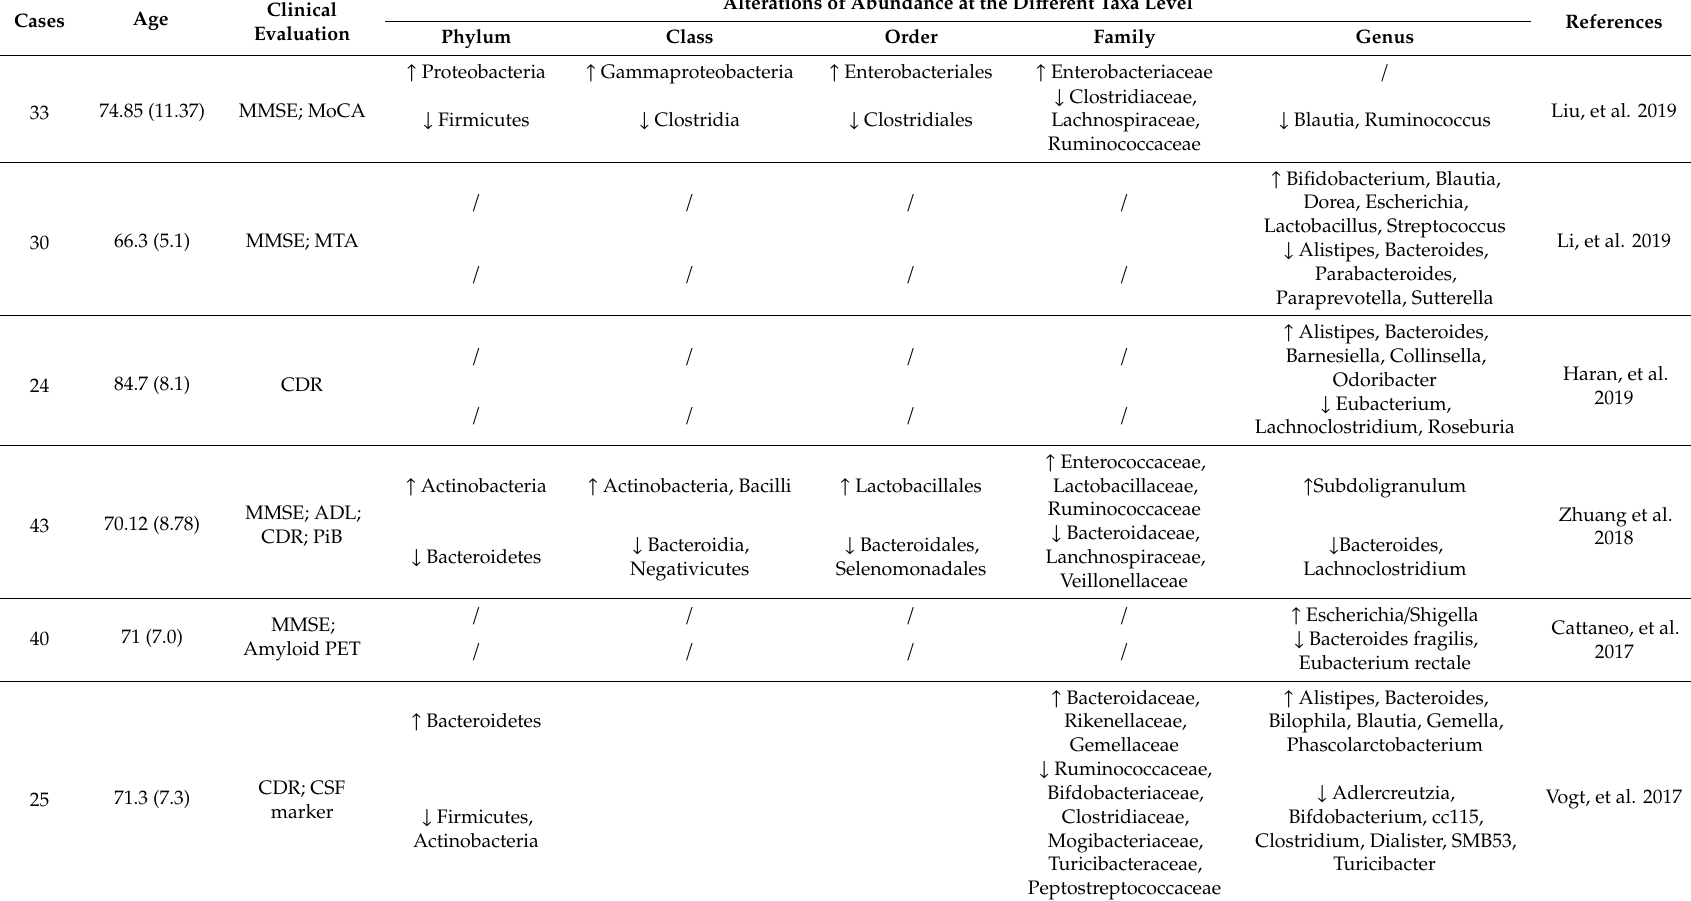
Table 1. Gut microbiota alterations in patients with Alzheimer’s